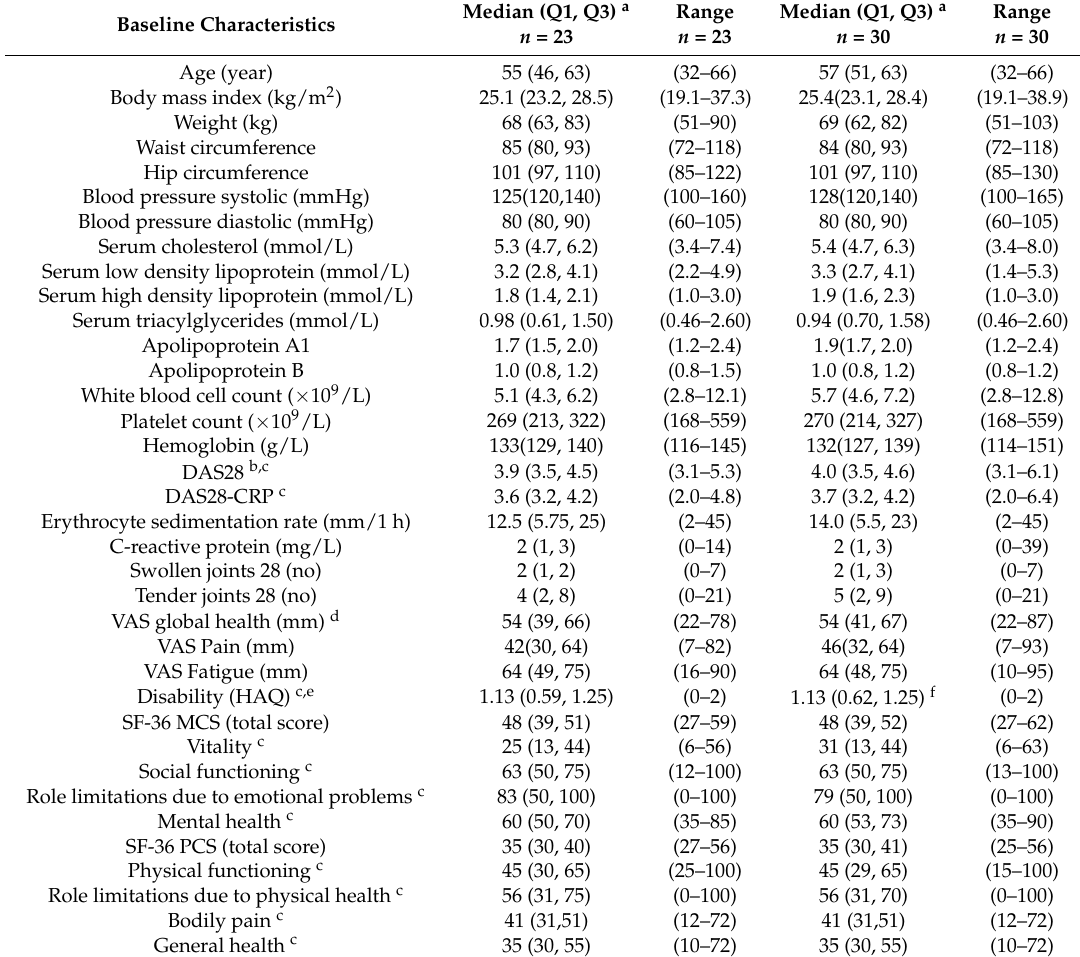
Table 1. Baseline characteristics. MCS, physical component score; PCS, physical component score.